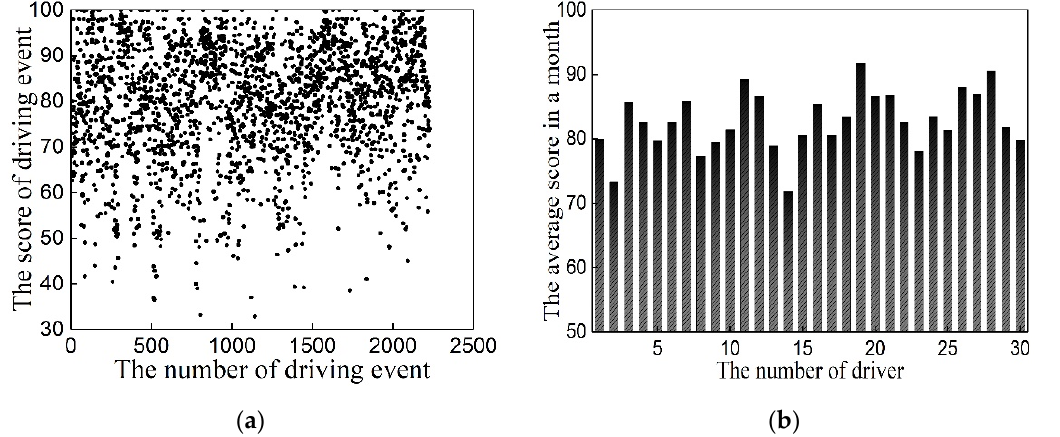
Figure 18. The evaluation result of driving behaviour: ( a ) The score distribution of driving events; ( b ) The score for every driver. ( b ) The score for every driver.